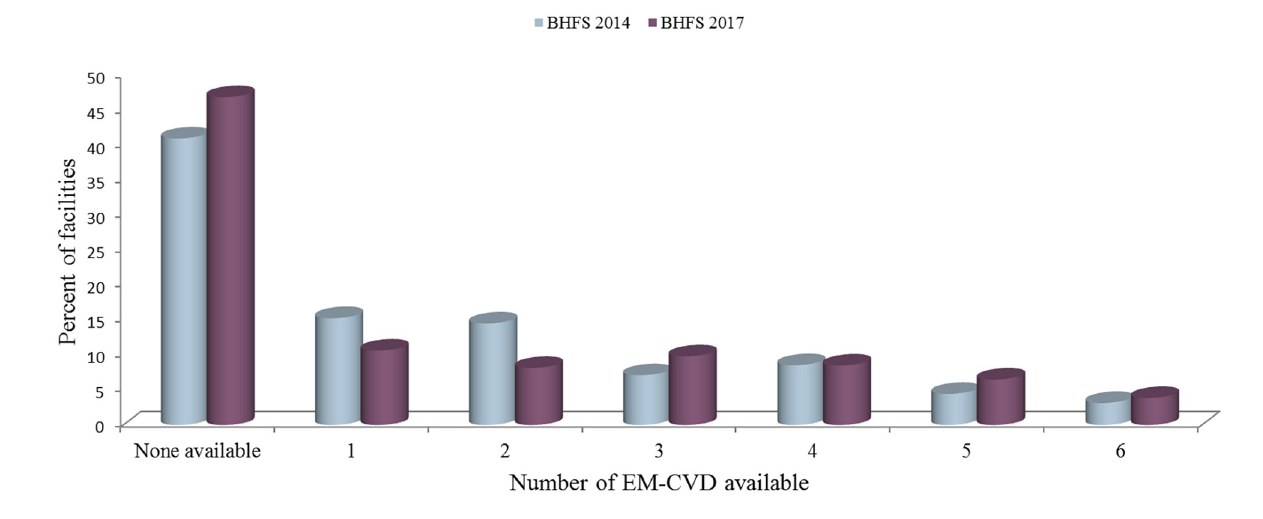
Fig 2. Number of essential medicines for CVD available in sampled facilities, BHFS 2014 and 2017.